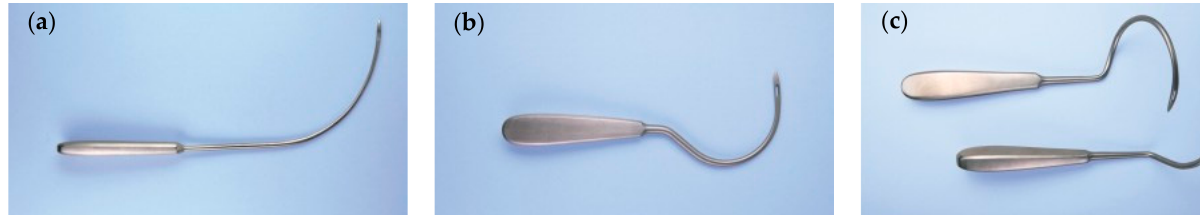
Figure 3. Applicators used in ( a ) TVT method and ( b , c ) in TOT method .